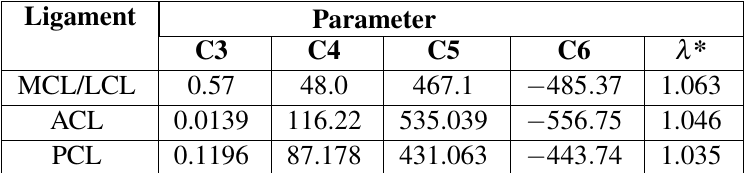
Table 1 Material properties of each ligament (/MPa)